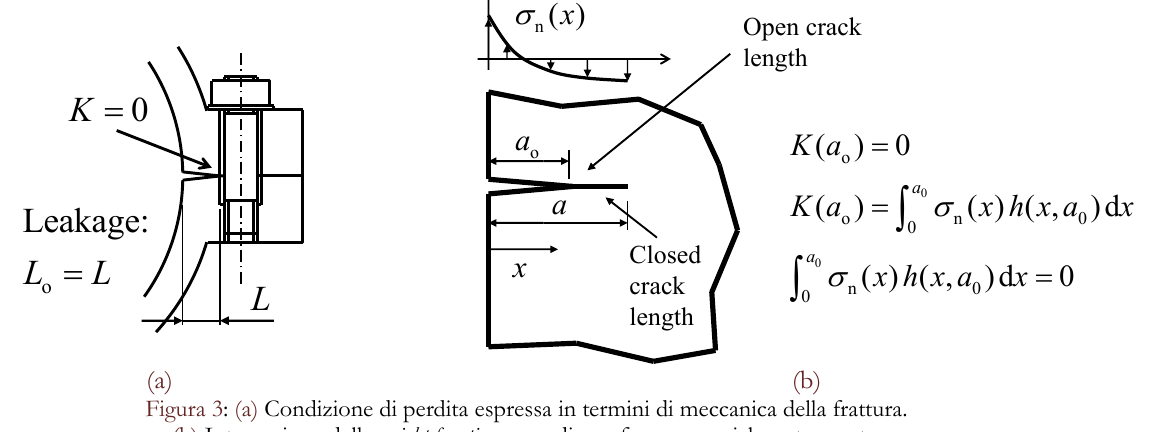
Figura 3: (a) Condizione di perdita espressa in termini di meccanica della frattura. (b) Integrazione della weight function , caso di una fessura parzialmente